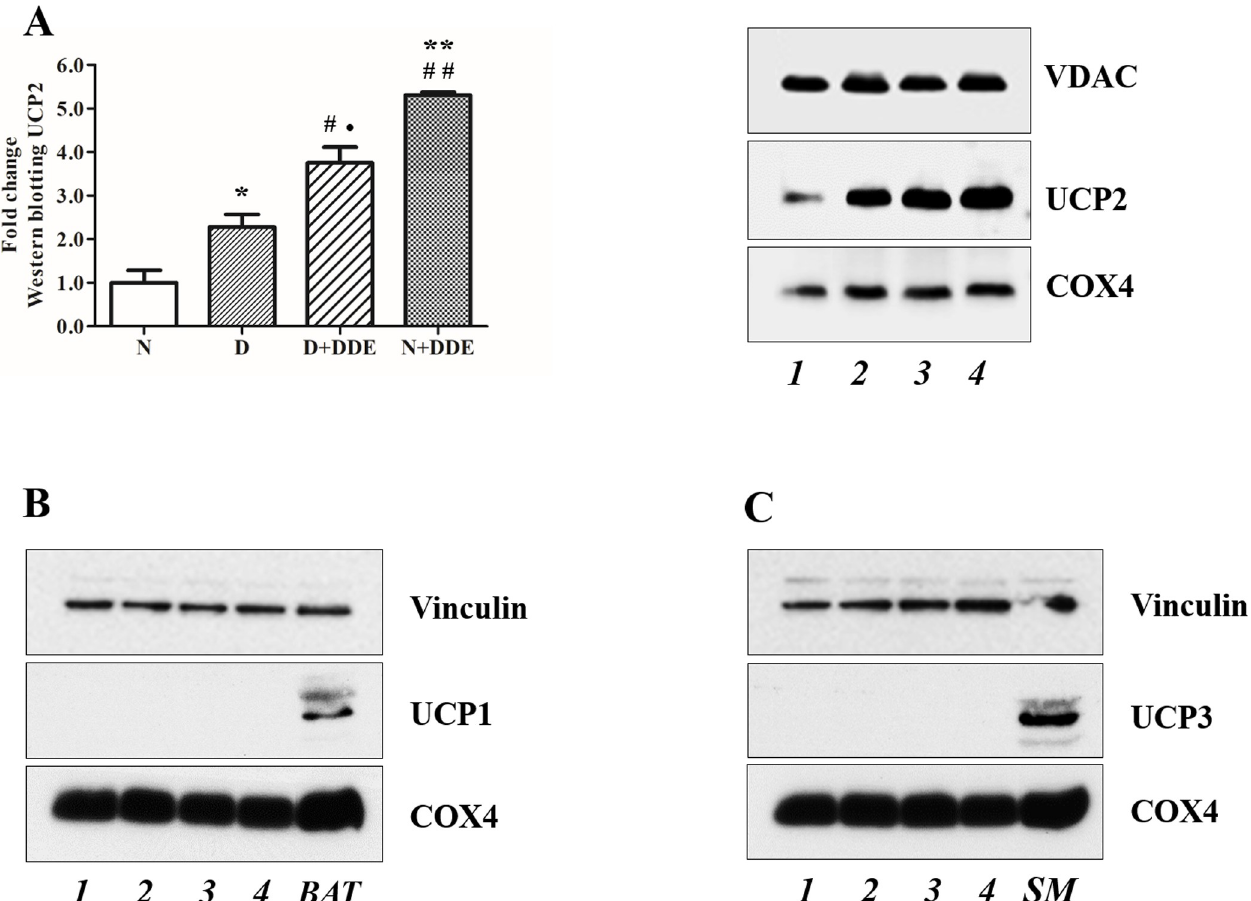
Fig 9. UCP2 Western blotting. (A) Western blotting for the mitochondrial protein UCP2. The amount of UCP2 protein content was normalized to COX4 and converted in fold change, compared with rats fed with a standard diet (N group). (B) Western blotting for UCP1; (C) Western blotting for UCP3. Significance of differences for UCP2 protein levels are shown: � p < 0 . 05 vs. N; �� p < 0 . 01 vs. N; # p < 0 . 05 vs. D; ## p < 0 . 01 vs. D; • p < 0 . 05 vs. N+DDE. Lines legend: 1, N; 2, D; 3, D+DDE; 4, N+DDE.